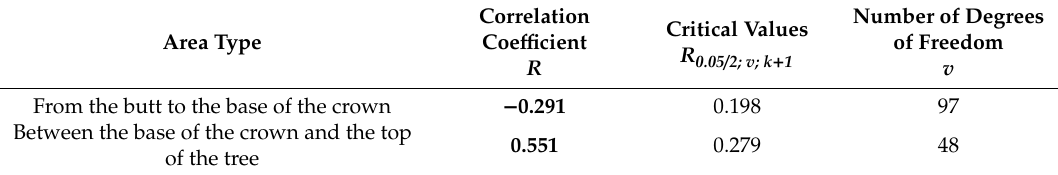
Table 9. Two-sided tests of the significance of correlation coefficients between the average density of Table 11. Two-sided tests of the significance of correlation coe ffi cients between the average density of birch wood and its location at the height (at the significance level p = 0.05). birch wood and its location at the height (at the significance level p =